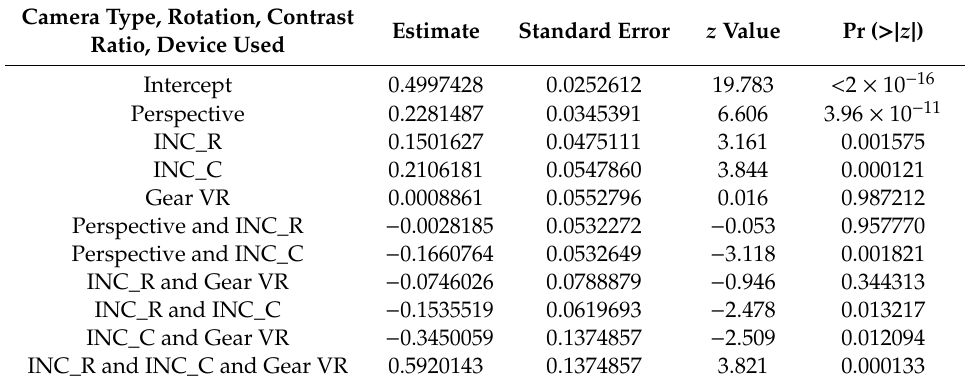
Table 38. Logistic regression analysis results of the four variables models allowing interactions. Camera Type, Rotation, Contrast Ratio, Device